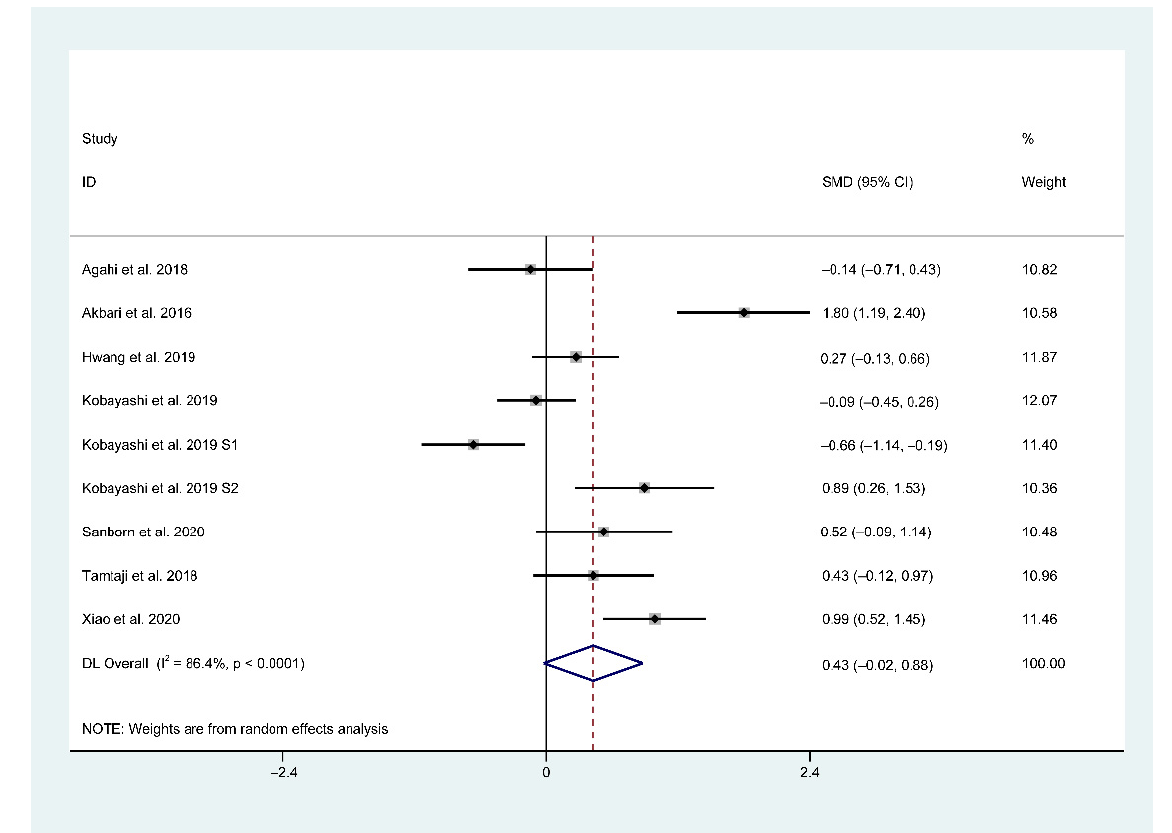
Figure 3. Forest plot of standardized mean difference (SMD) of probiotics on cognition. Weights were assigned according to the number of subjects and SD using STATA 14. A random-effect model was applied to the meta-analysis. The sizes of the data markers represent the weight of each study, and the diamond indicates the overall estimated effect. SMD, standardized mean difference.